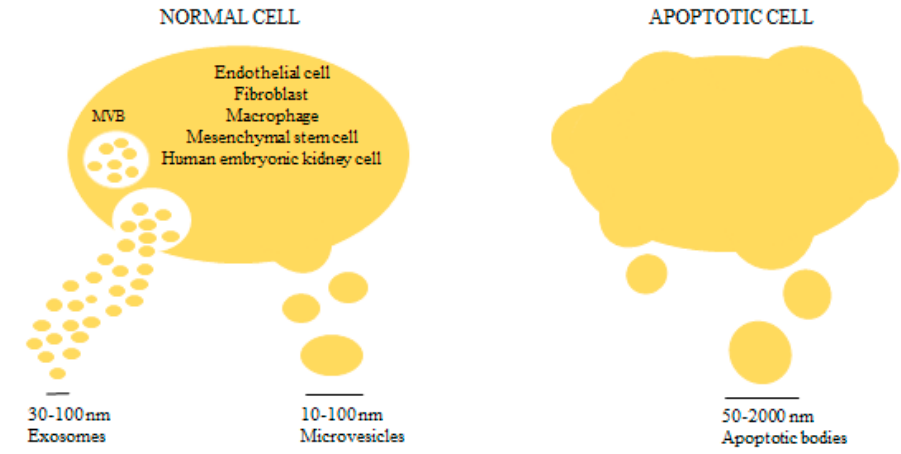
Figure 1. EVs mechanism of intercellular communication. Depending on the physical and chemical properties of the cell compartments of biogenesis, EVs show different dimensions.